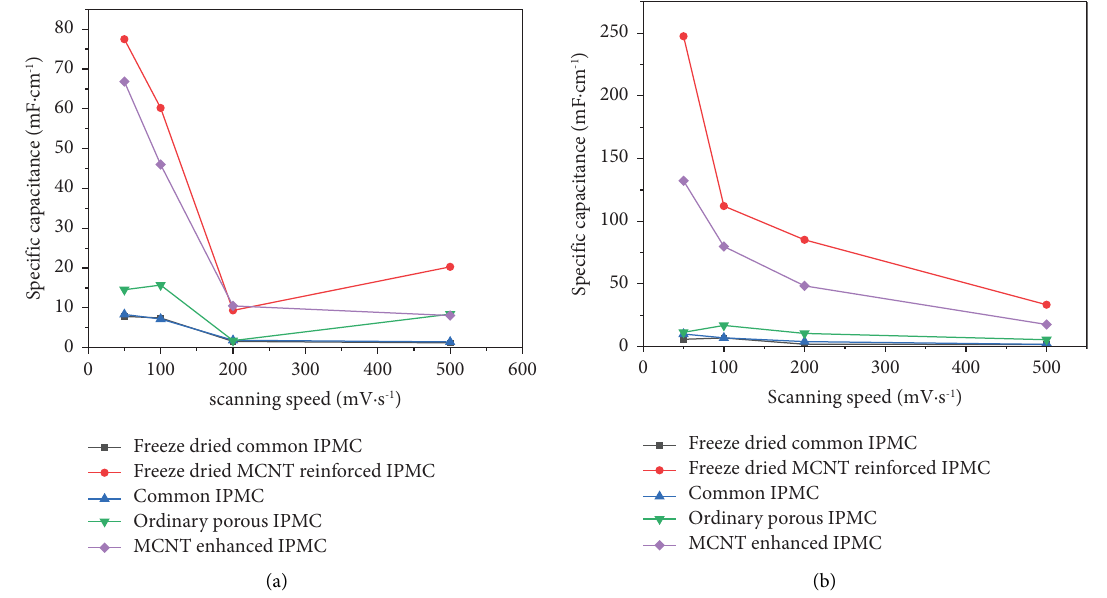
Figure 7: Comparison of specifc capacitance in diferent scanning intervals: (a) − 1V-0 V; (b) − 1V–1